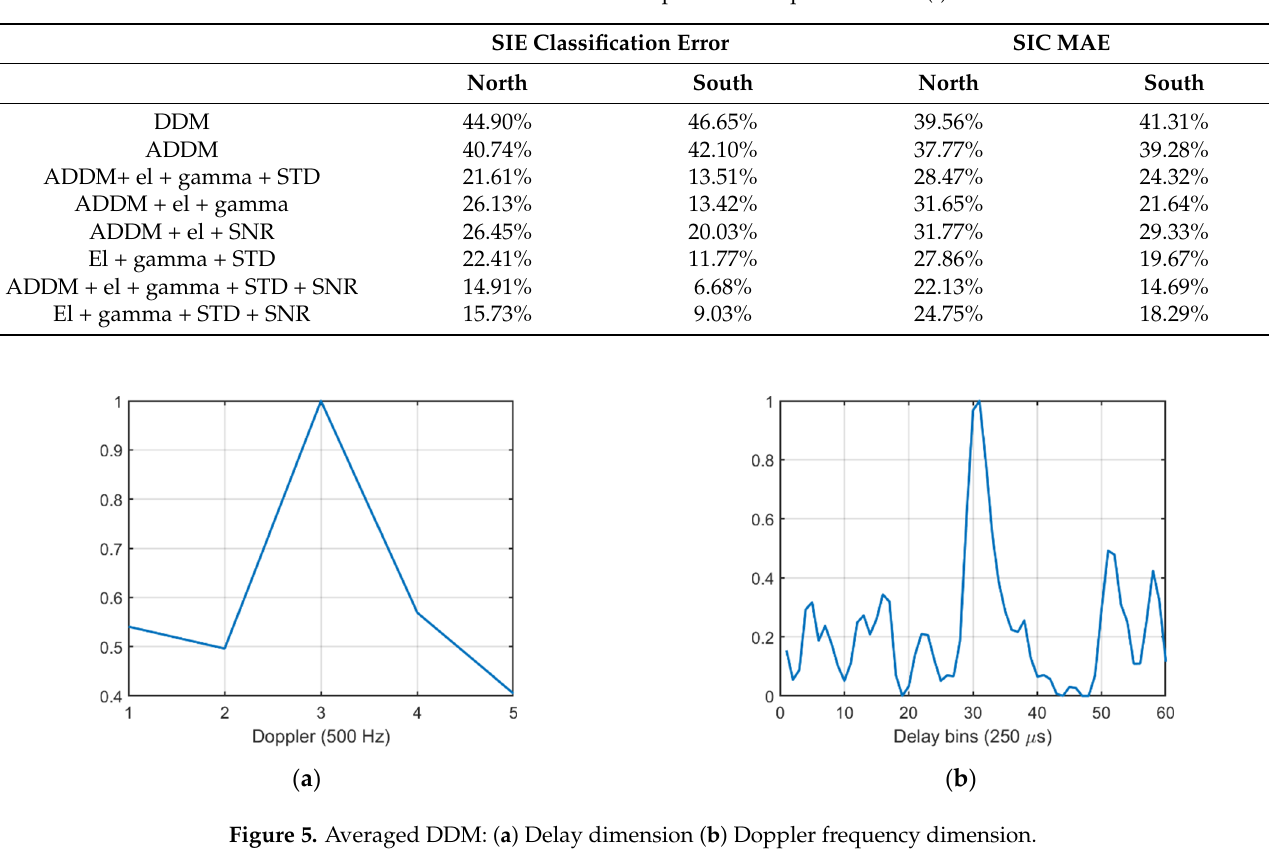
Table 3. GNSS-R NN error with respect to the input variables (I).